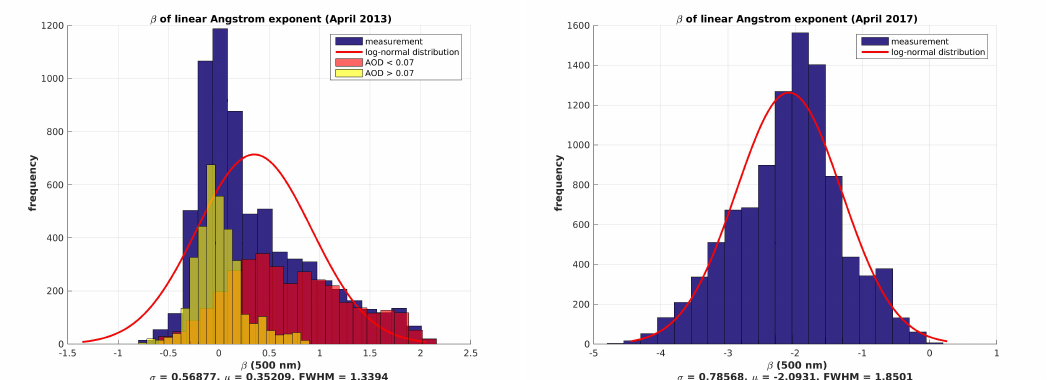
Figure 9. Histograms of the spectral slope β for April 2013 (left) and April 2017 (right). The blue bars are the total amount of measurements, whereas the yellow and red bars only represent the fraction of α > 1.5 and α < 1.5, respectively.